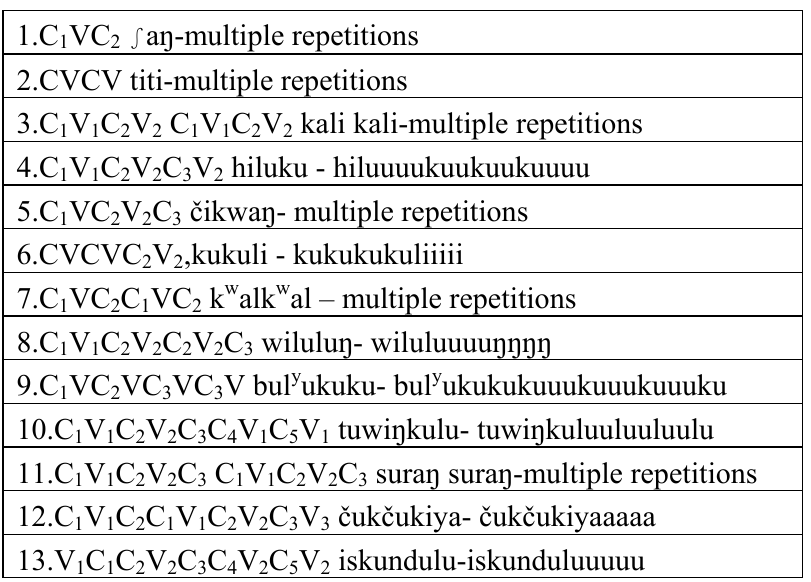
Table 2. Bird call sound